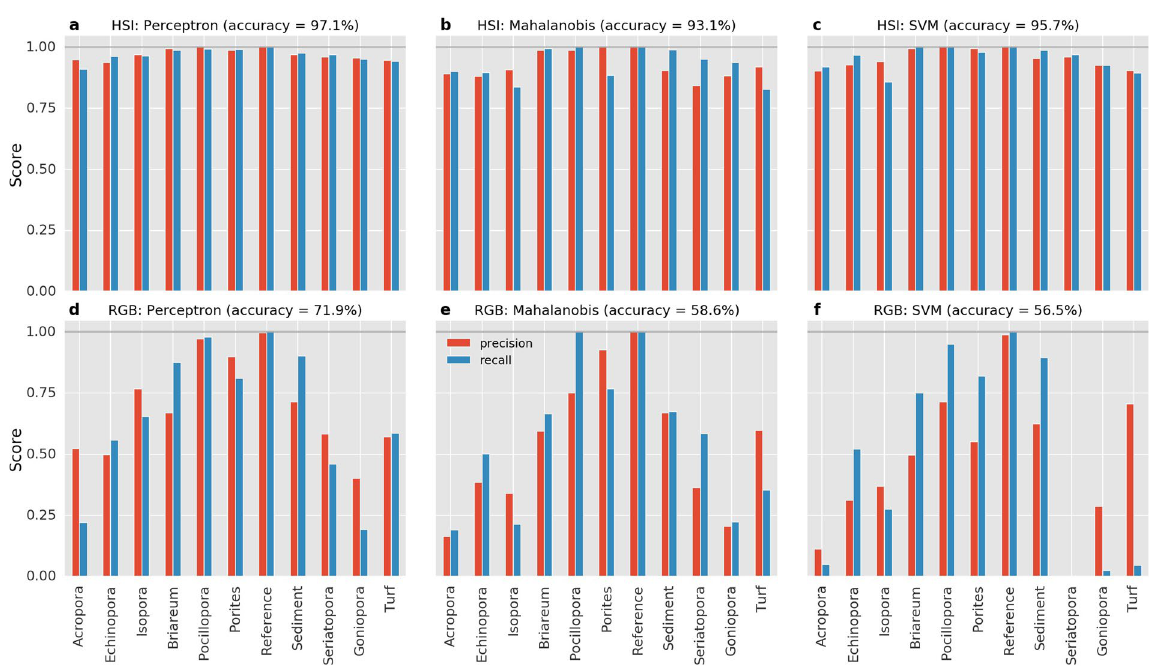
Figure 5. Performance of classifier models trained on annotated pixels (1.3% of total) from the test transect image (see Fig. 4a) were evaluated through metrics of precision, recall and overall accuracy. Metric scores are shown for classifiers trained separately on HSI (panels a–c) and RGB (panels d–f) pixels using three different algorithms (see panel text). Precision (also called producer accuracy) measures the ability of the classifier to avoid false positives and recall (also called user accuracy) is the ability to find all samples of a particular